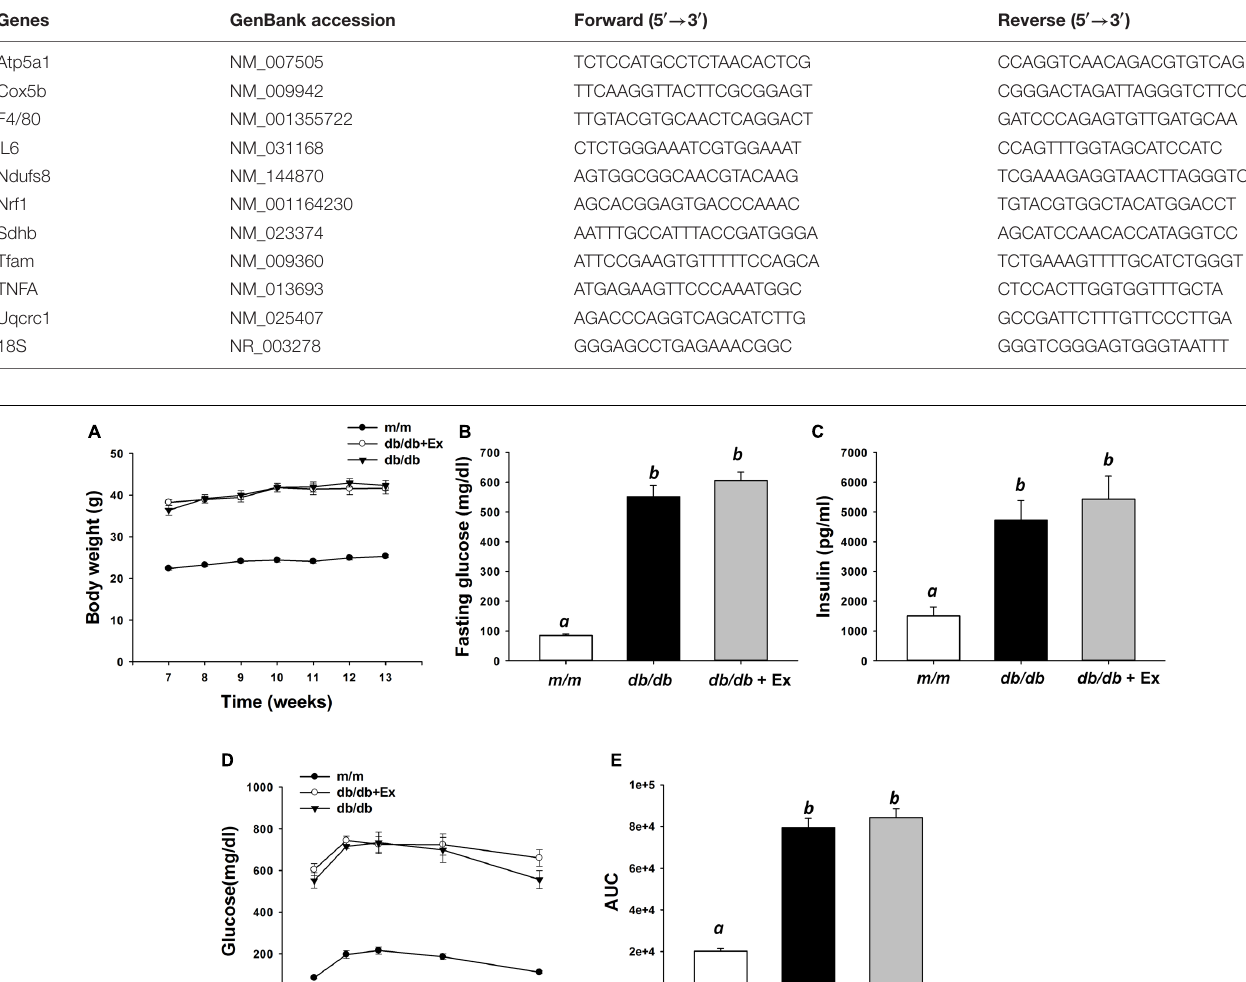
Frontiers in Physiology |